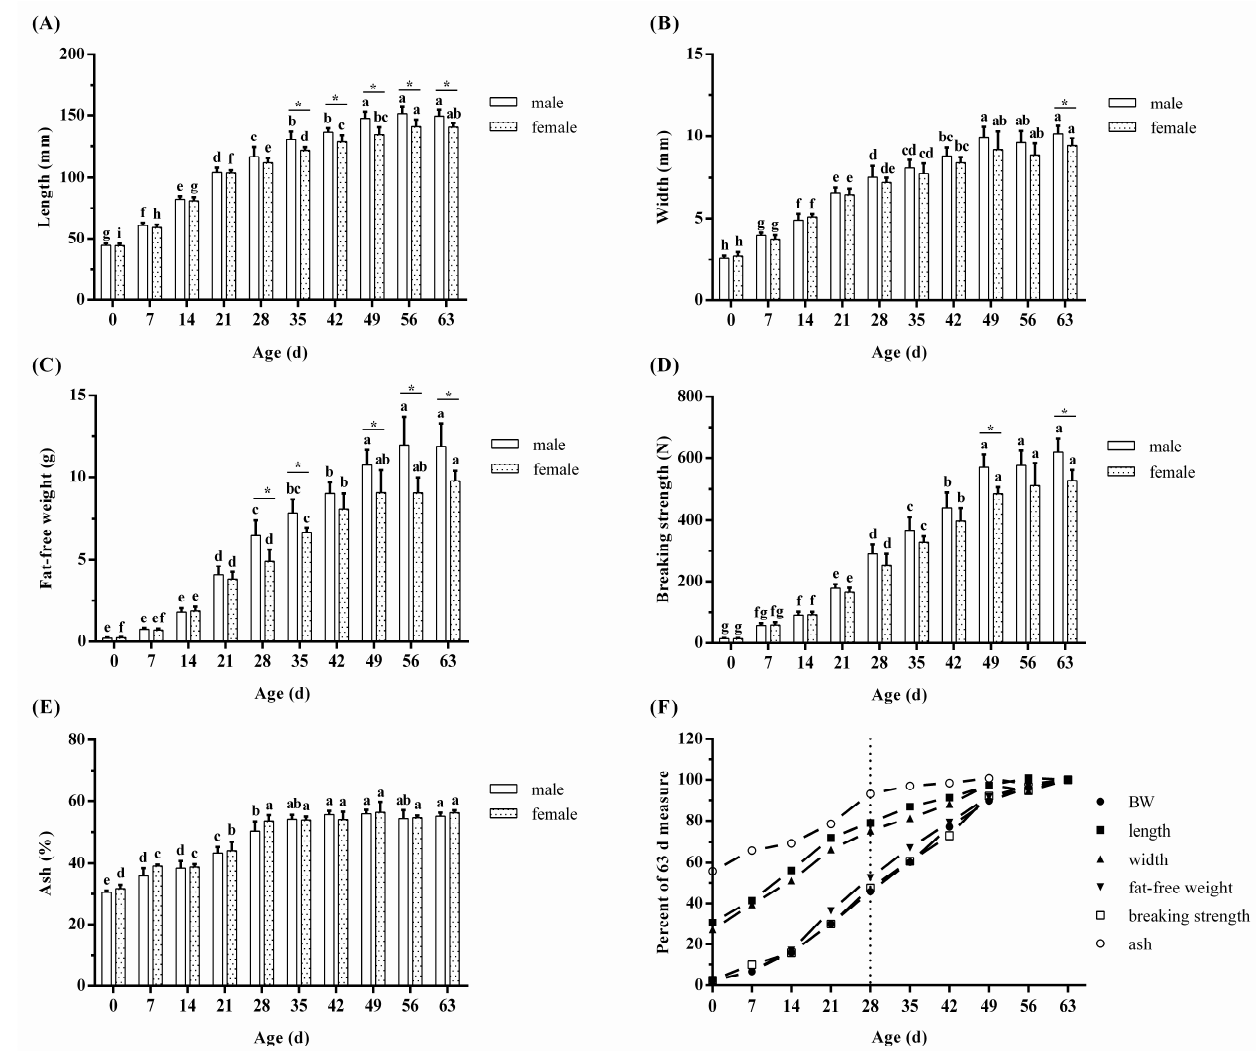
Figure 4. The dynamic change of tibia traits for male and female goslings from hatching to 63 d of age. The changes include the length ( A ), width ( B ), fat-free weight ( C ), breaking strength ( D ), and ash content ( E ). Values are given as means and standard deviation (n = 8). Values followed by different letters (a–i; age) or * (sex) differ significantly ( p < 0.05). ( F ) Fractional growth of BW and tibia length, width, free-fat weight, breaking strength, and ash as a proportion of the measure at 63 d of age. Means represent 16 birds per age (combined male and female).